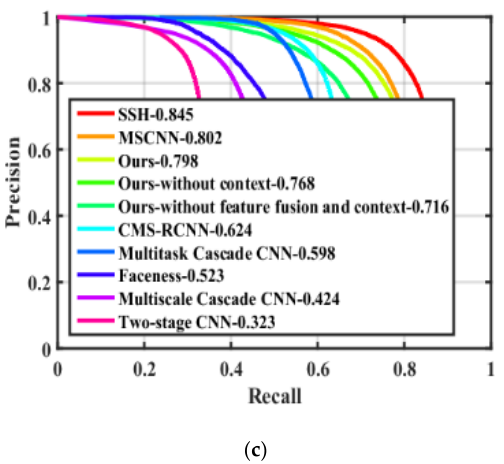
Figure 5. Precision-recall curves on WIDER FACE validation set. ( a ) Precision-recall curves on ‘easy’ subset; ( b ) Precision-recall curves on ‘medium’ subset; ( c ) Precision-recall curves on ‘hard’ subset.